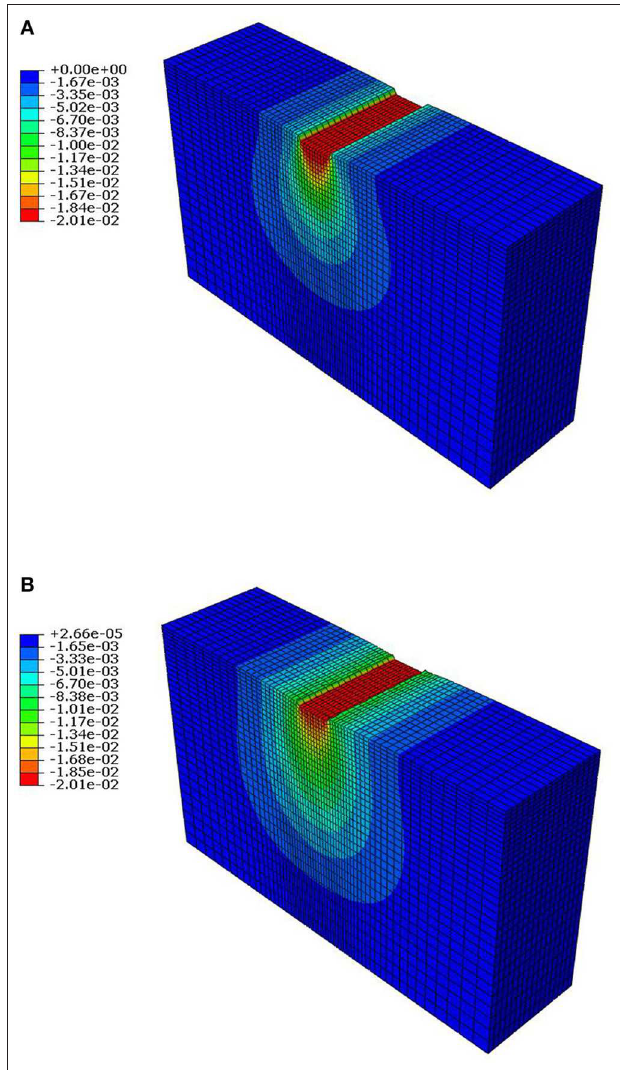
FIGURE 12 | Typical settlement profiles of foundation bed (FEM data, s/B = 20%). (A) Unreinforced. (B) Geocell